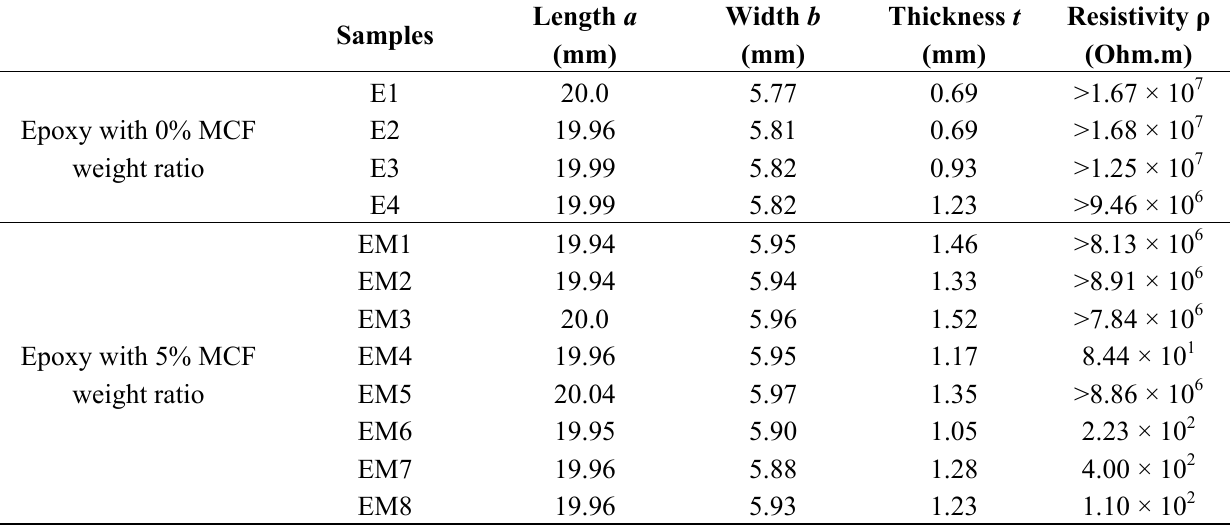
Table 3. Dimensions and measured electrical resistivity of epoxy samples with 0% or 5% recycled milled carbon fibre (MCF) weight